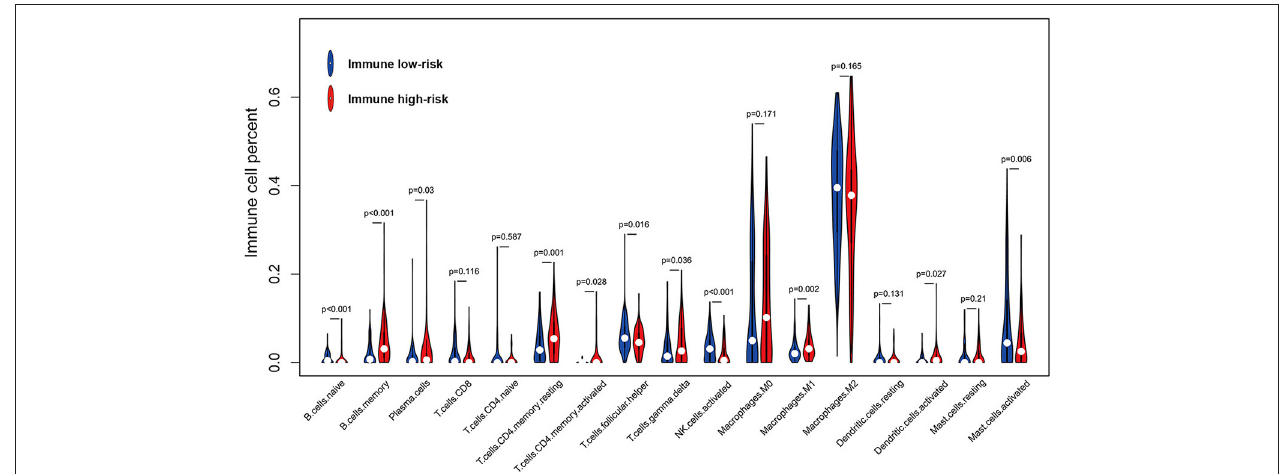
FIGURE 3 | Violin plot for comparing the fractions of 17 types of immune cells included in the IIRPSS between immune low- and high-risk groups in TCGA.